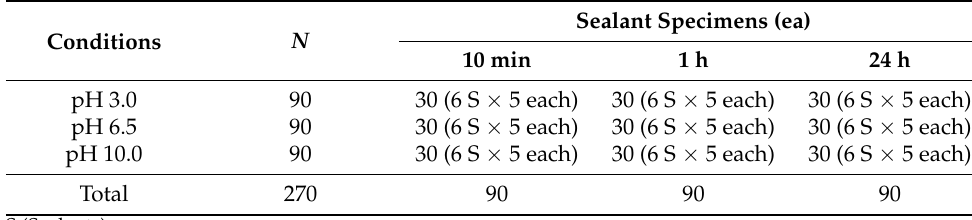
Table 3. Sealant specimens for BPA release